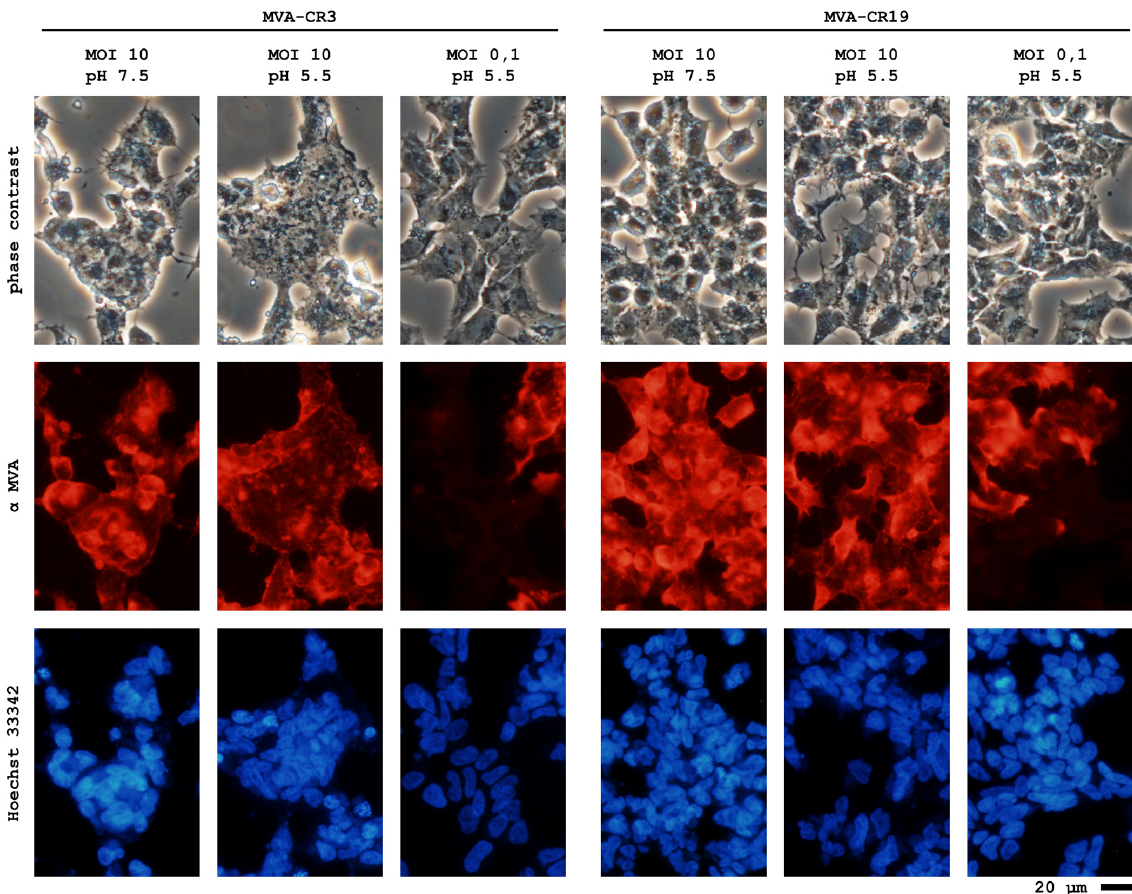
Figure 5. Syncitia formation appears to be more pronounced in adherent cell monolayers of CR.pIX cells infected with wildtype MVA compared to MVA-CR19. CR.pIX adherent cell monolayers were infected with MVA with a MOI of 10 and 0.1 as a